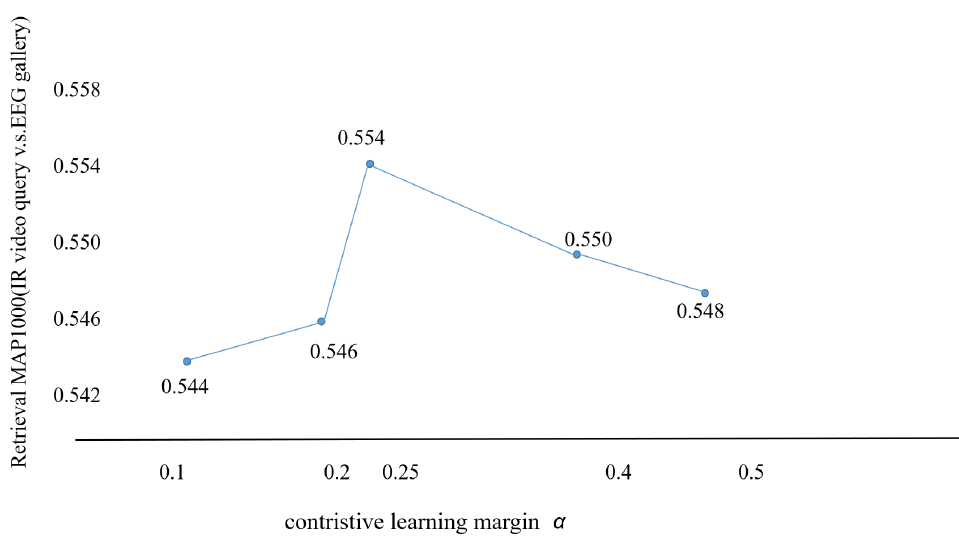
Figure 5. Performances on different values of the contrastive learning margin α (defined in Equation (5)).